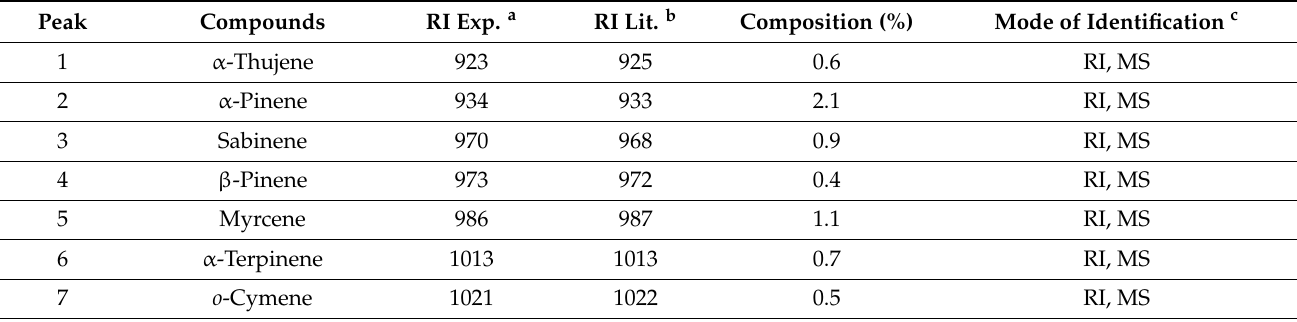
Figure 1. The major phytoconstituents of M. chamomilla : ( A ) (E) ‐β‐ Farnesene; ( B ) Germacrene D; and ( C ) α‐ Bisabolol oxide A. Table 1. Essential oils from M. chamomilla and their chemical